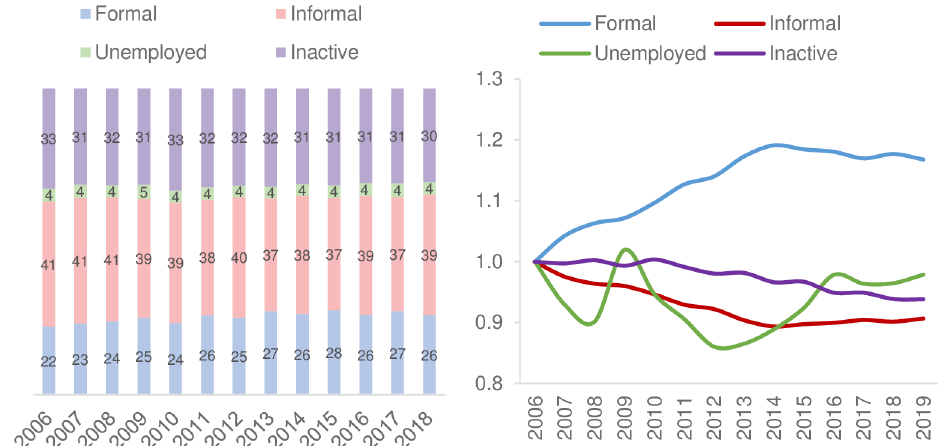
Fig 1. Labor market developments in Latin America. (A) Percentage Distribution of the working-age population. (B) Labor Market Dynamics (2006 = 100). Source: Prepared with data from the IDB’s Labor Markets and Social Security Information System (SIMS) database, 2020. Latin America is a simple average with information from 16 countries.